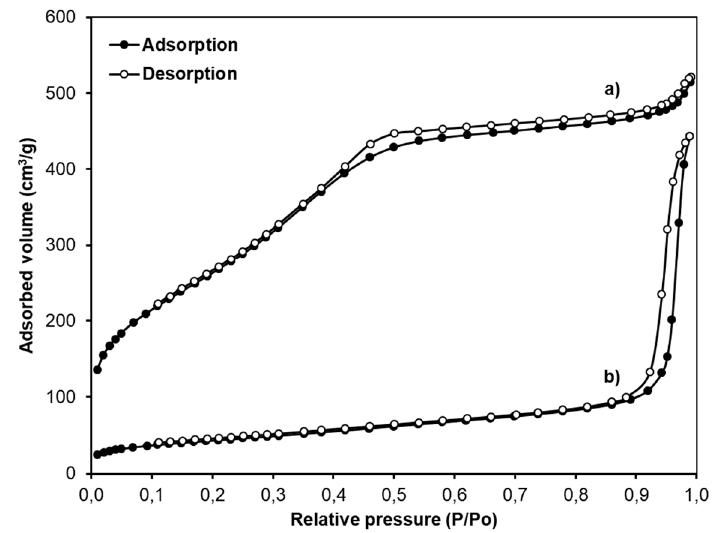
Figure 6. Nitrogen adsorption–desorption isotherms of HMSN ( a ) and PNS ( b ).